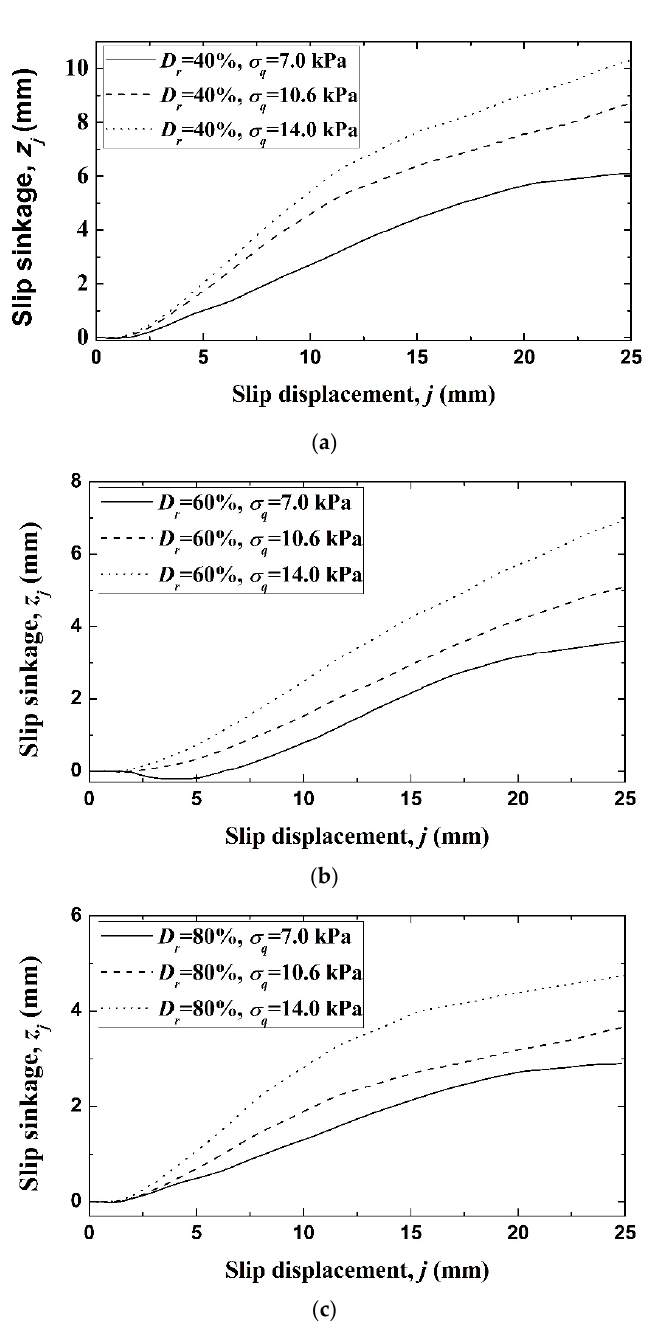
Figure 9. Slip sinkage and slip displacement relationships for ( a ) D r = 40%, ( b ) D r = 60%, and ( c ) D r = 80%. Excluding the slight upward slip sinkage that occurred at the beginning of shearing for T4 (relative density of 60% and vertical stress of 7.0 kPa), downward slip sinkage occurred under all test conditions. The extent of the downward slip sinkage increased with slip displacement. However, the rate of increase gradually decreased. This behavior is similar to the tendency of the increase in vertical displacement of the soil sample as shearing progressed in the direct shear test. However, while upward vertical displacement is normally observed in the direct shear test for dense soil due to the volumetric expansion [31], in this experiment, downward slip sinkage also occurred in soil with a